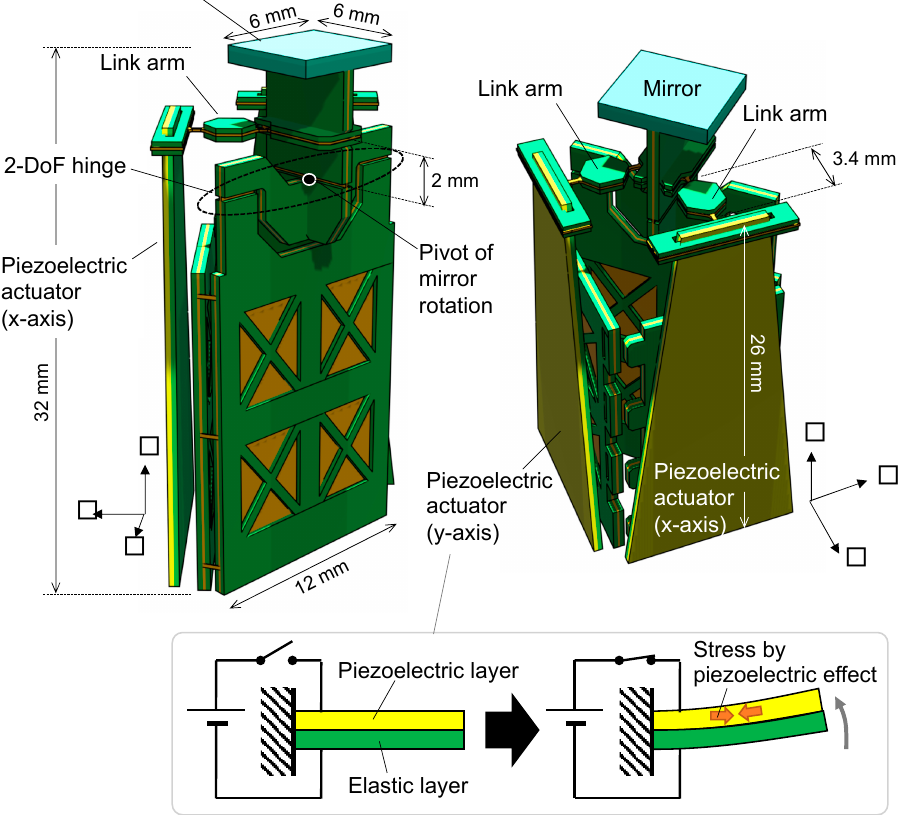
Figure 2. Structure of fabricated scanner.